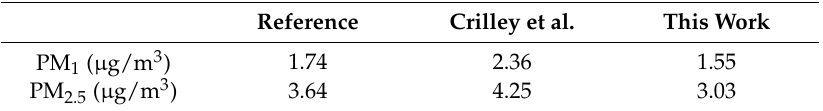
Table 4. Correlation values for Alphasense OPC-N2 sensors used during this study.